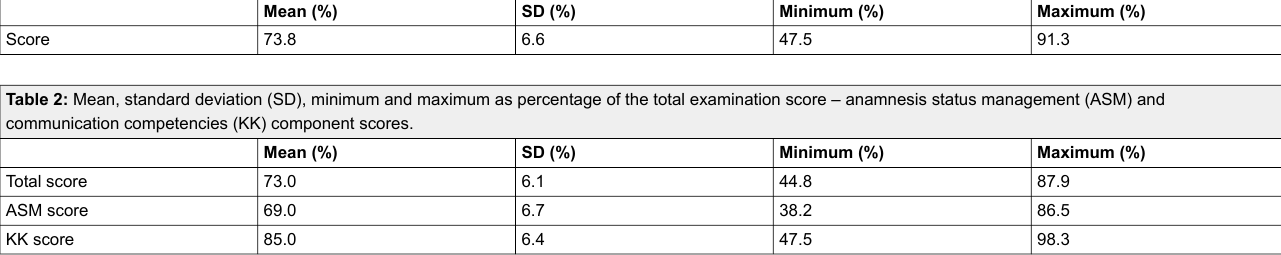
Table 1 : Mean, standard deviation (SD), minimum and maximum as percentage of the total examination score.